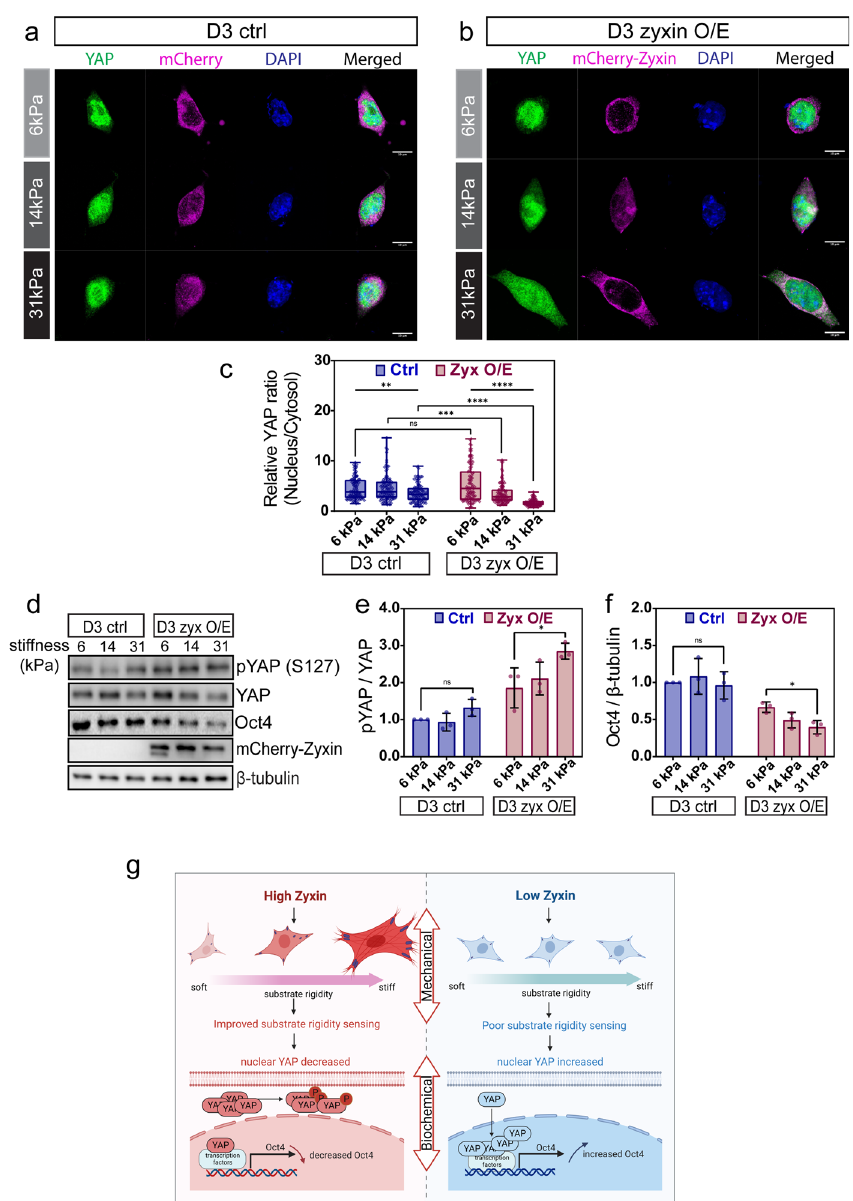
Fig. 7 Zyxin overexpression deactivates YAP and downregulates Oct4 level in a force-dependent manner. a D3 control and b D3-zyxin overexpressing cells were seeded on increasing substrate rigidity of 6, 14, and 31 kPa. YAP localization was examined by immunostaining. DAPI was used to observe cell nucleus. Z-stacked images with maximum intensity projection were shown. Representative images out of three biological repeats were presented. Scale bar: 10 μ m. c Nucleus/Cytosol YAP ratio in D3 cells transfected with either control or mCherry-Zyxin plasmids were analyzed and plotted ( N = 100). Kruskal – Wallis test was used to test the differences among the three rigidities and Mann – Whitney U -test was used to test the differences between the control and zyxin overexpression groups at each rigidity. In the box and whisker plots, the center line is the median, the box-bounds are the 25th and 75th percentiles, and the whiskers are the 0.05 and 0.95 percentiles. d D3 cells were transfected with either control or mCherry-Zyxin plasmids and then collected for western blot analysis using antibodies against pYAP, YAP, Oct4 and mCherry. β -tubulin was used as loading control. e , f Densitometry analysis of e pYAP (normalized against total YAP, N = 3) and f Oct4 (normalized against β -tubulin, N = 3). Two-tailed unpaired Student ’ s t -test was used to test the differences between 6 and 31 kPa in each condition. Values presented as fold change using control cells plated on 6 kPa as the internal reference. Results were from three independent experiments. Error bars represent standard deviations. * P ≤ 0.05; ** P ≤ 0.01; *** P ≤ 0.001; **** P ≤ 0.0001; ns, not signi fi cant. g Substrate rigidity sensing is improved in cells with high zyxin levels through the modulation of f-actin, focal adhesion and traction stress. As a result, there is increased phosphorylation of YAP (S127) and its retention in the cytosol, leading to lower nuclear YAP levels and reduced Oct4 expression (left panel). Substrate rigidity sensing is poor in cells with low zyxin levels. YAP is predominantly localized in the nucleus which can then promote Oct4 expression (right panel). Mechanical and biochemical cues work together through focal adhesions to regulate embryonic stem cells fate.